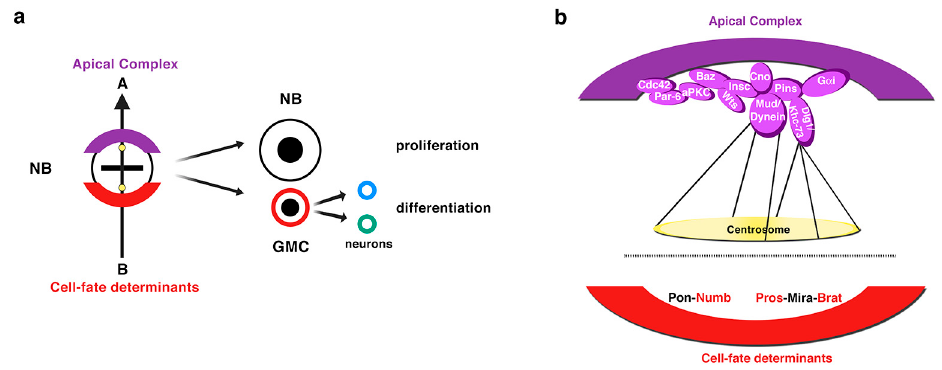
Figure 2. Drosophila neuroblasts (NBs), the neural stem cells of the central nervous system (CNS), divide asymmetrically. ( a ) NBs divide asymmetrically to give rise to another NB and a ganglion mother cell (GMC), which receives the cell-fate determinants that induce a differentiation program in this cell. The GMC divides asymmetrically through a terminal division to give rise to two different neurons of glial cells. The sibling NB that does not receive the cell-fate determinants keeps on dividing. A group of proteins apically located at the cortex of metaphase NBs (the “apical complex”) is in turn crucial for the basal sorting of the cell-fate determinants, as well as for the correct orientation of the mitotic spindle along an apico-basal axis of cell polarity previously established. ( b ) A diagram showing the most representative components of the apical complex and the cell-fate determinants Numb, Pros and Brat. Pon and Mira are adaptor proteins of Numb (Pon) and of Pros and Brat (Mira) (modified from Carmena, Fly, 2018).